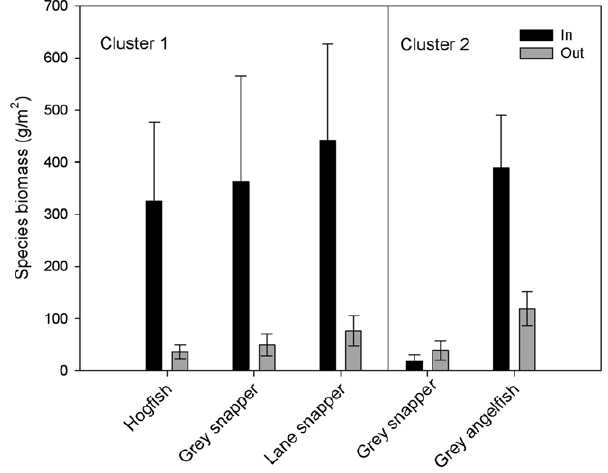
Figure 4. Species-specific fish reserve response by patch reef seascape grouping. Only species showing statistically significant (P , 0.05) differences between in (dark bars) and non-reserve (light bars) sites within a patch reef type are shown. The left panel shows fish species from Patch Type I; the right panel shows fish species from Patch Type